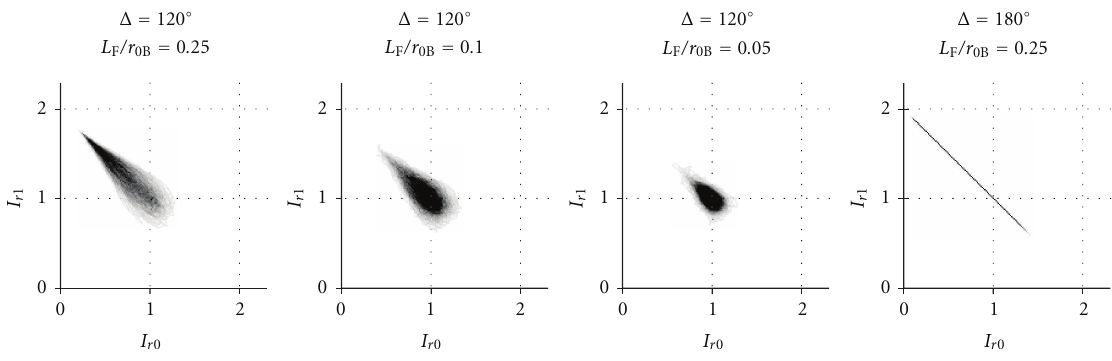
Figure 11: The same data as in Figure 8 but obtained with M outer = 20 r 0 B .